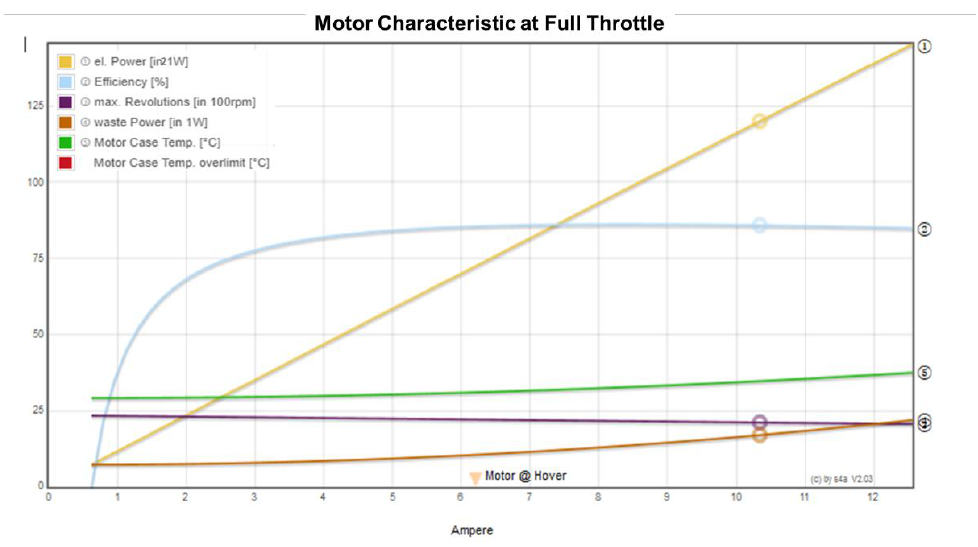
Fig. 6. Drone configuration for source selection